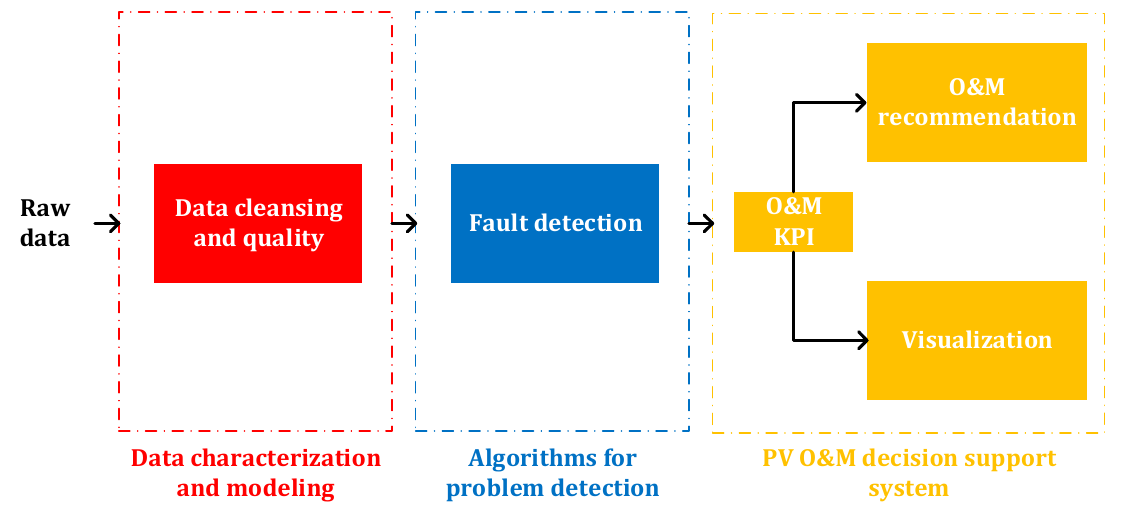
Figure 2. Data process for the generation of O&M recommendations by the DSS engine.